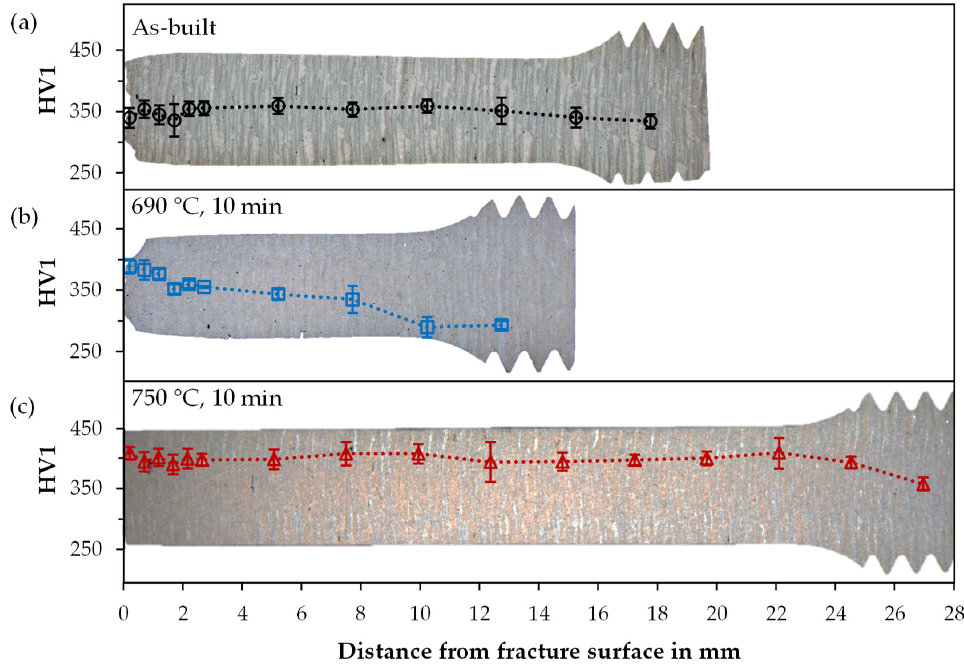
Figure 4. The hardness curves along the longitudinal axes of tested tensile samples ( a ) as-built and after intercritical annealing for 10 min at ( b ) 690 °C and at ( c ) 750 °C.